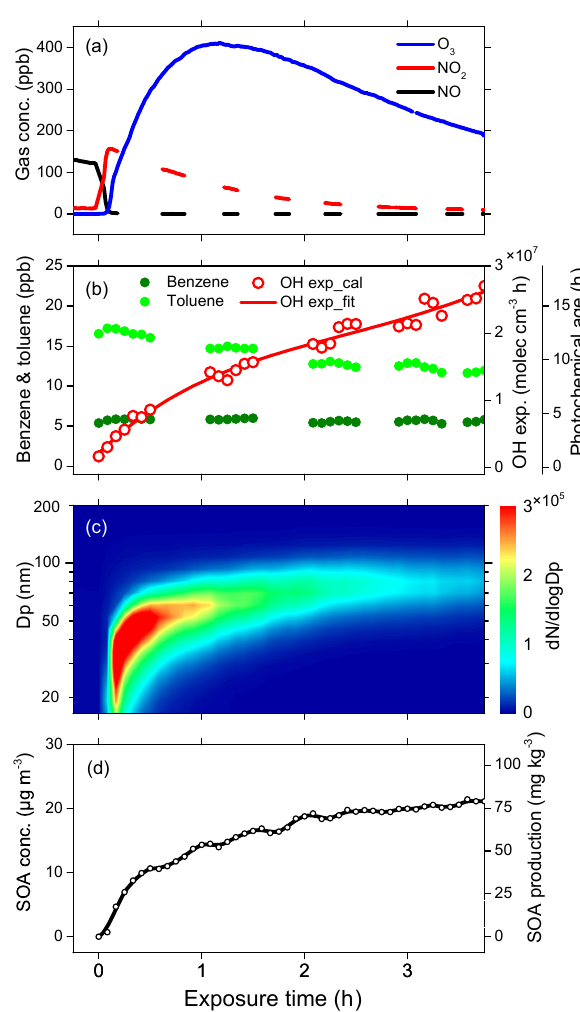
Figure 2. Evolution of gas-phase species (a, b) , particle size distri- bution (c) , and SOA concentration and production (d) during a typi- cal chamber experiment (V2). OH exposure and photochemical age are calculated based on the ratios of benzene and toluene concen- trations, assuming that OH concentration is 1 . 6 × 10 6 moleccm − 3 . The SOA mass concentration is obtained by intergrading size dis- tribution of particles inside the chamber on the basis of measured particle density. The measured SOA mass concentration is corrected according to the particle wall loss curve as well as the dilution effect for both particles and gas